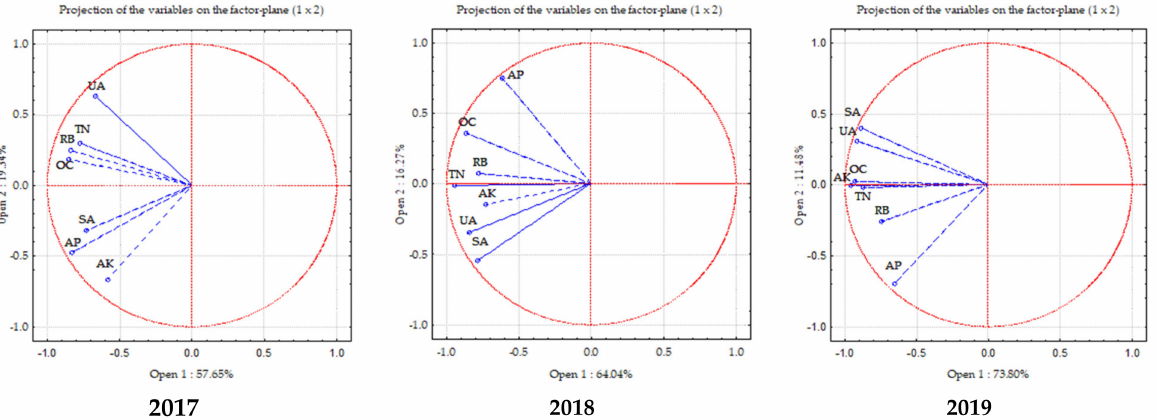
Figure 4. PCA of sole, binary, and trinary crops in 2017–2019. Note. UA—urease activity; TN— total nitrogen; RB—root dry biomass; OC—organic carbon; SA—saccharase activity; AP—available phosphorus; AK—available